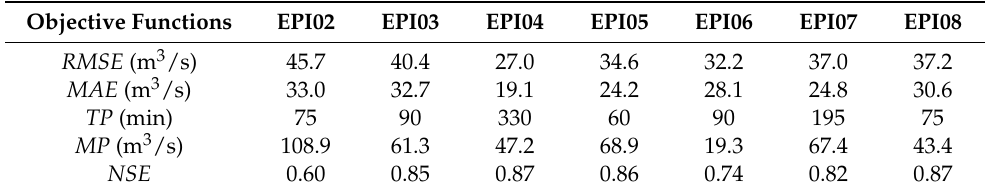
Table 6. Weighted values of the objective function values in the three hydrometers considered in the study for the events used in the calibration and validation phases. The results correspond